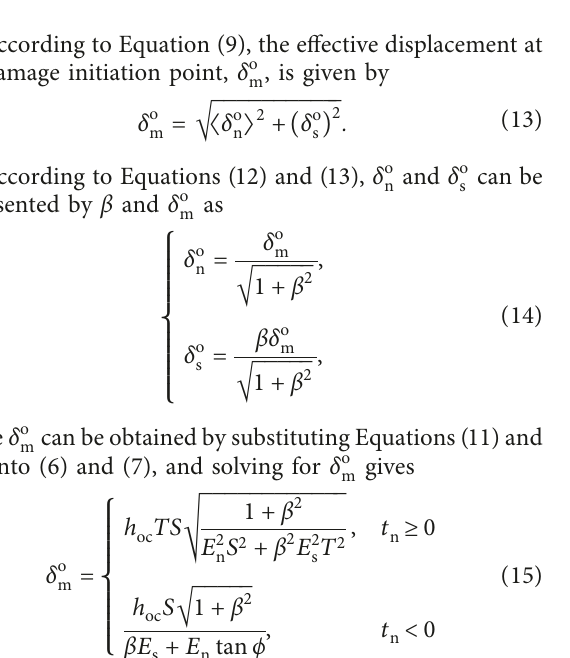
Figure 7: The concept of damage variable D